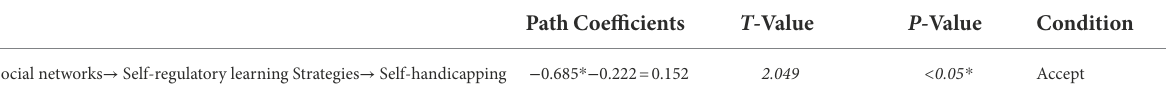
TABLE 6 The relationship between social networks and self-handicapping with the mediating role of self-regulatory learning strategies.